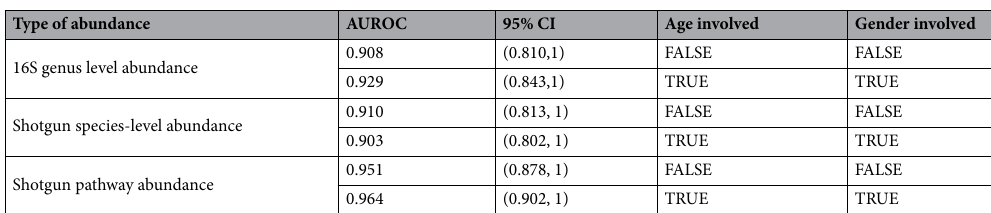
Table 4. The prediction performance of random forests algorithm measured by AUROC and its 95% confidence interval based on the genus level abundance profiles of 16S rRNA gene, microbial species and pathway abundance from shotgun sequencing